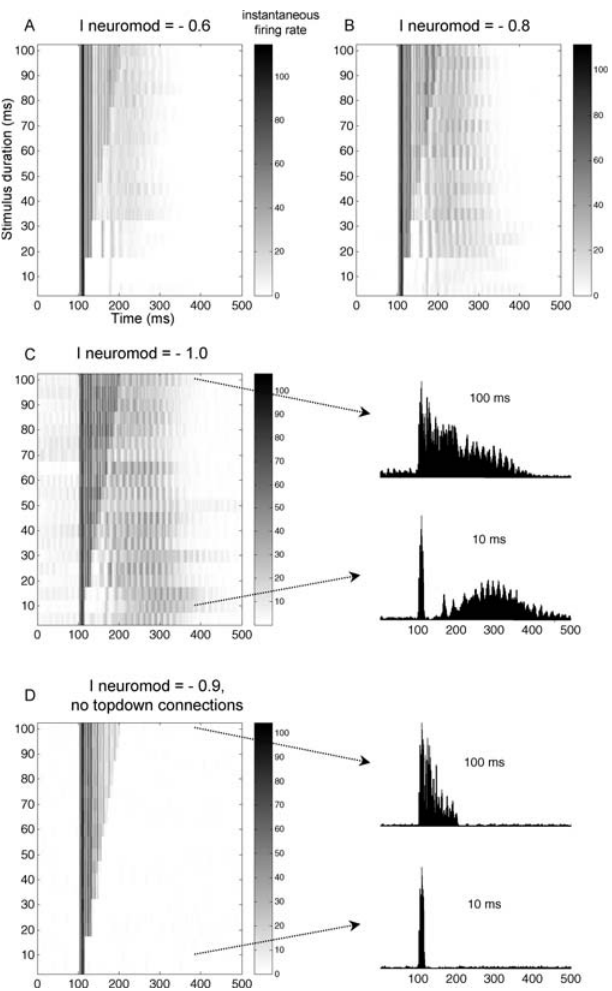
Figure 5. Reverberant Activity in the Global Workspace Model Imposes a Nonlinear Threshold on Incoming Stimuli Each panel shows the firing rate of pyramidal neurons in the lowest area A1 (coded by gray level) as a function of time (x-axis), in response to stimuli of variable duration (y-axis). Ignition is present when the duration of firing extends much beyond the duration of the stimulus, i.e., when a long tail of firing is present. In (A–C), the vigilance level—set by the ascending neuromodulation parameter I neuromodul —is progressively increased. This increase leads to a systematic change in the minimum duration necessary for ignition. Note that the figure is an average over 20 trials at each duration. Thus, the small trailing activation that can be seen in (A) and (B) even at durations below the threshold is due to a very small proportion of trials in which ignition did occur, due to stochastic variability, as further explained in Figure 6. The insets in (C) show the peristimulus- time histograms for stimulus of 10- or 100-ms duration, showing clearly the two firing peaks successively evoked by bottom-up activation and by top-down amplification. In a simulation in which top-down connections are disabled (D), the first peak is preserved, but the second peak is